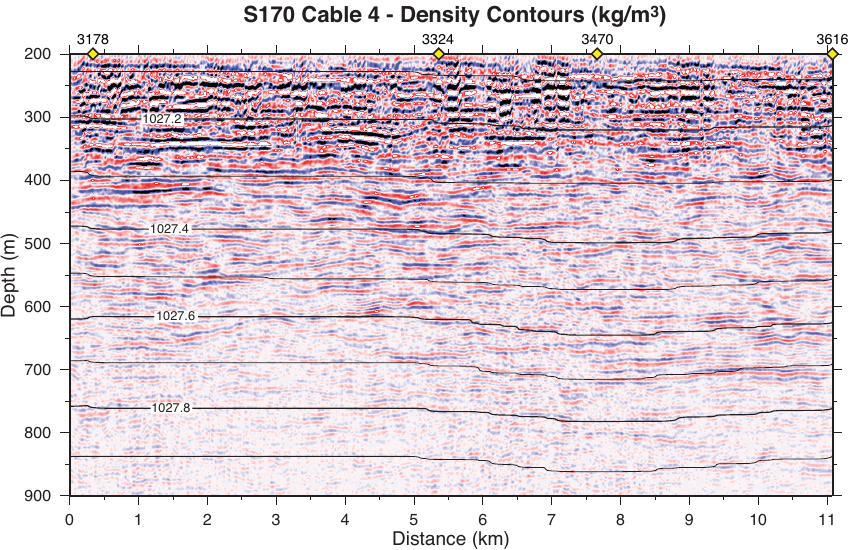
Fig. 3. The portion of the migrated image of swath S170, cable 4, source 1, that overlaps with XBT coverage is shown with isopycnals (kg/m 3 ) plotted on top of the image. Yellow diamonds at the top indicate locations of XBT casts; numbers correspond to nearest shot point.